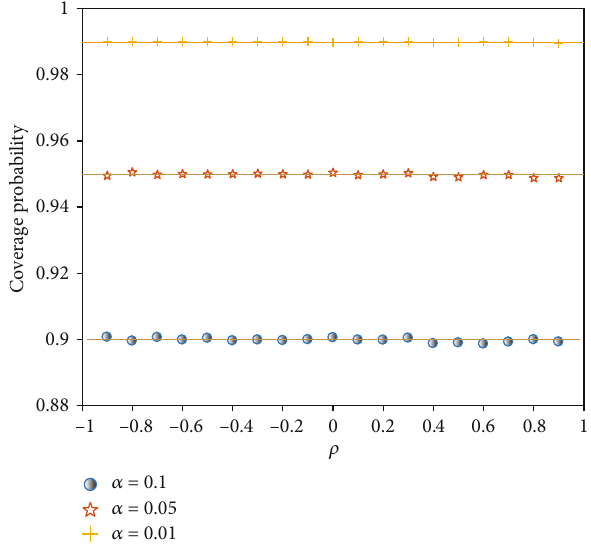
Figure 8: The coverage probability of estimative VaR forecast for the case of the ARCH(1) process; 1 − α = 0 : 9 (blue), 0.95 (brown), and 0.99